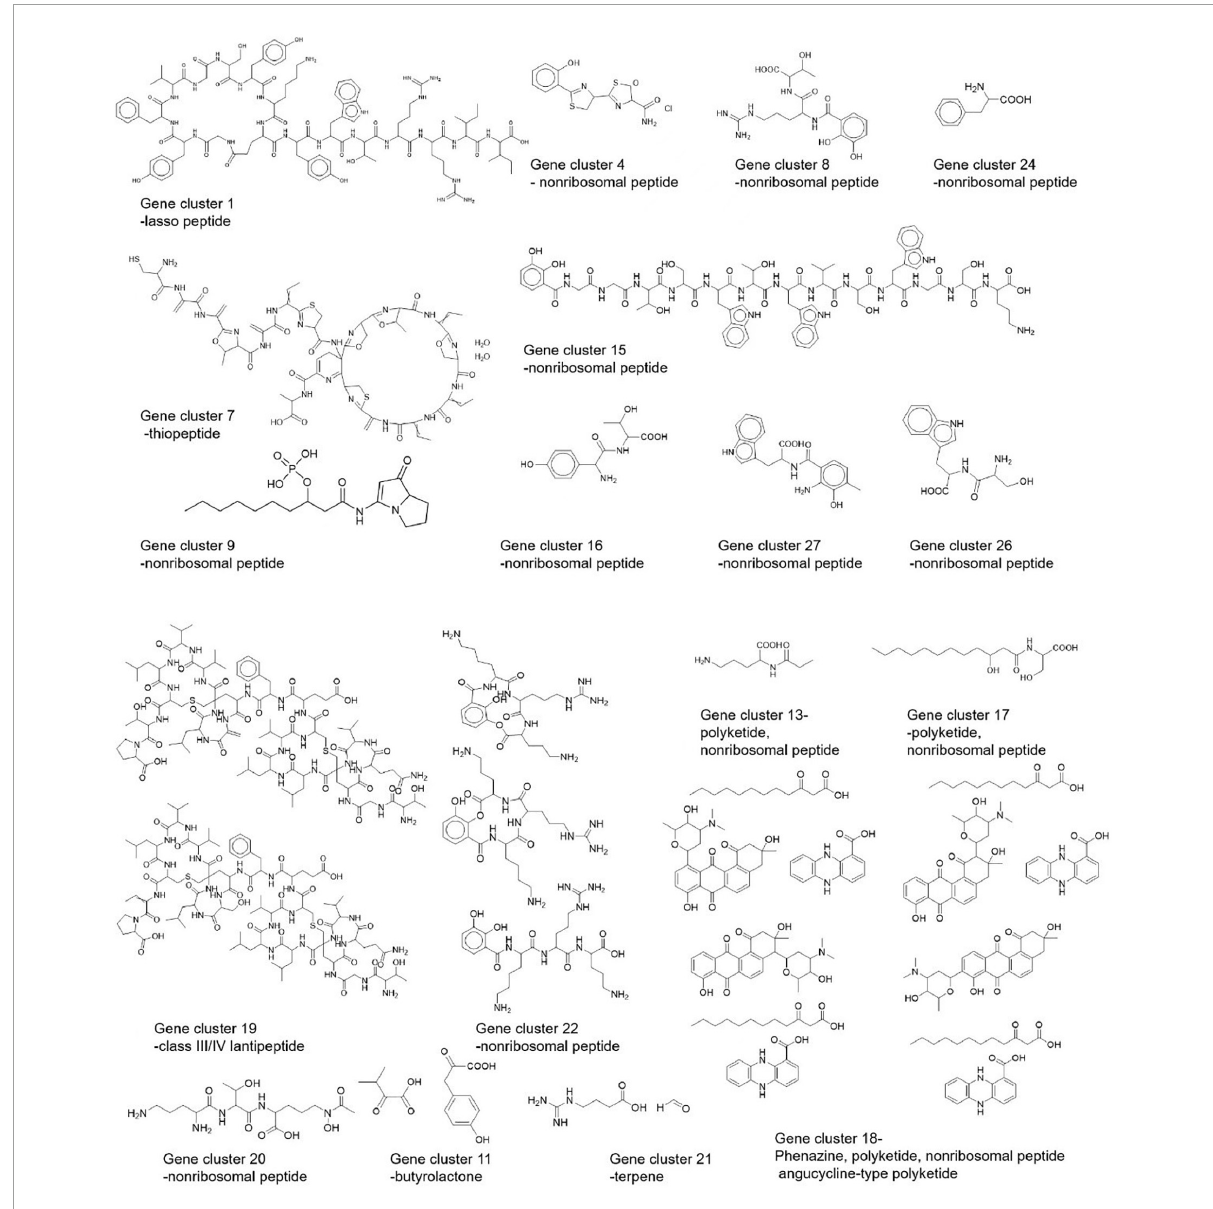
FIGURE8 Predicted structures of Streptomyces strain CS-7 secondary metabolites by PRISM.